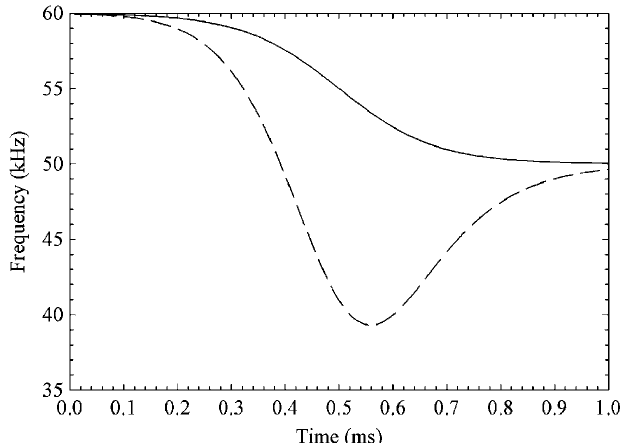
FIG. 8. If the average frequency (cid:7) (cid:6) t (cid:7) = 2 (cid:1)t (solid) decreases like the hyperbolic tangent from 60 to 50 kHz, then the instan- taneous frequency _ (cid:7) (cid:6) t (cid:7) = 2 (cid:1) (dashed) also transitions from f f , but undershoots. In this case, both the transverse focusing 1 frequency and the phase advance overshoot.